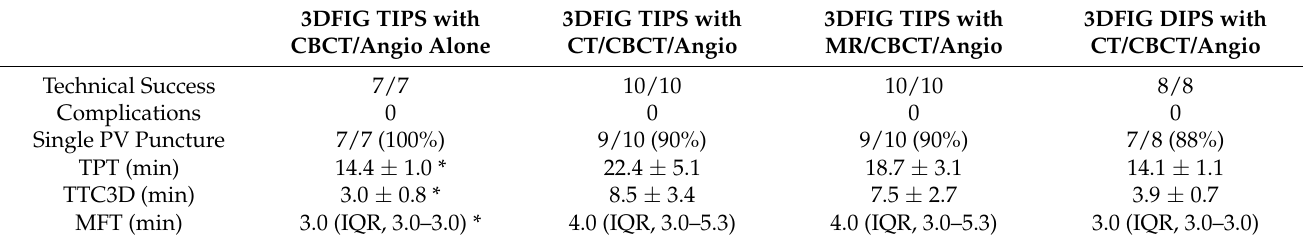
Table 1. Technical outcomes of the 3DFIG TIPS